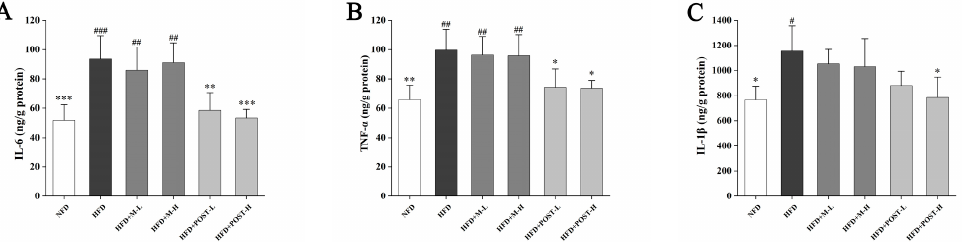
Figure 4. POST reduces hepatic inflammation in HFD mice. The concentration of cytokines in the liver, ( A ) IL-6, ( B ) TNF- α , ( C ) IL-1 β . Compared to HFD, * p < 0.05, ** p < 0.01, and *** p < 0.001; Compared to NFD, # p < 0.05, ## p < 0.01, and ### p < 0.001.